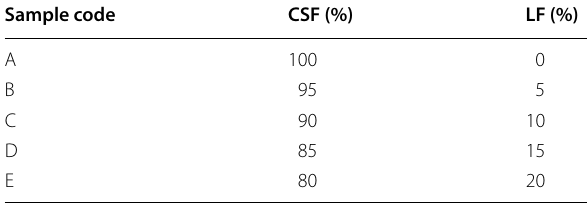
CSF corn silk flour, LF lemon flour